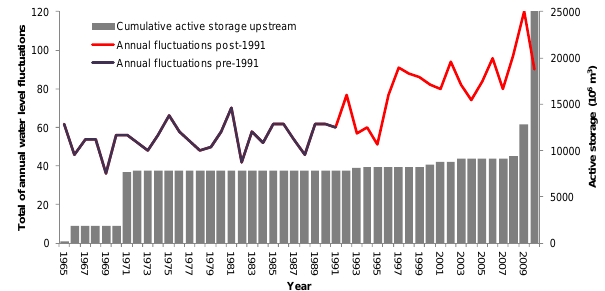
Figure 3. Temporal trend in water level fluctuations and cumulative active storage upstream of Pakse.